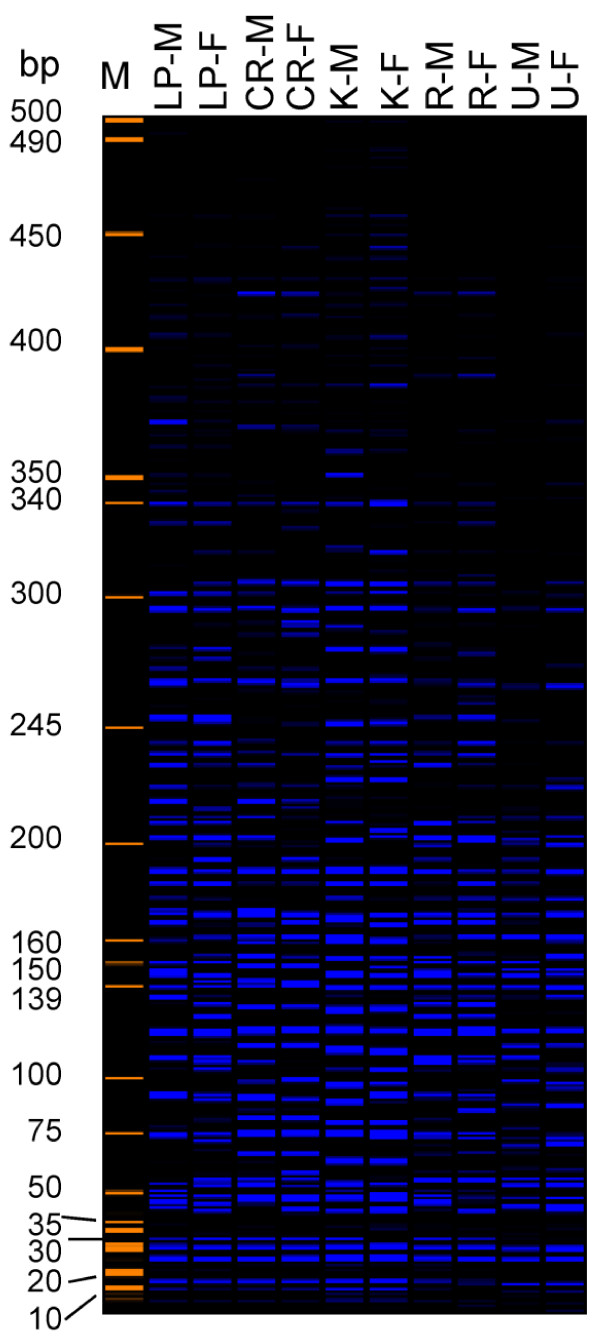
 Transposon display of ATon-I in different strains ofA. aegypti. M, size marker; A female (F) and male (M) individual are shown for each strain. LP, Liverpool; CR, Costa Rica; R, Rockefeller; K, KHW; U, UGAL. The selective base “C” was used for selective amplification.